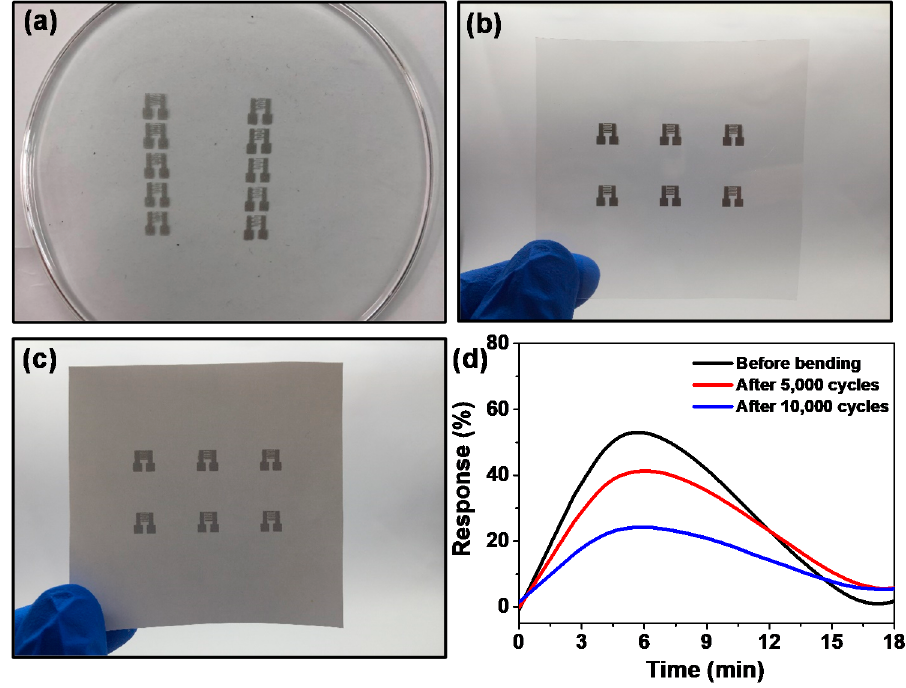
Figure 11. ( a ) Photograph of silver electrodes on PDMS. ( b ) Photograph of silver electrodes on paper. ( c ) Photograph of silver electrodes on PET. ( d ) Response and recovery curves of SnO 2 /ZnO-3 gas sensors on flexible silver electrodes before and after 5000, 10,000 bending cycles in 0.1 ppm NO 2 .